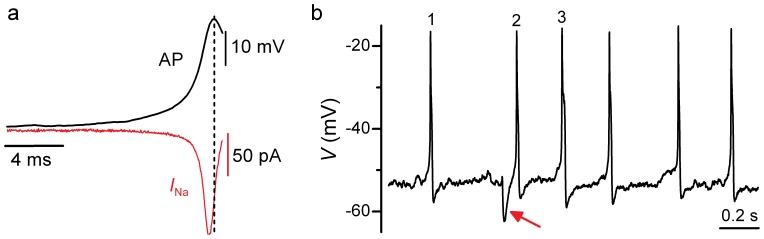
Role of the Na+ current in action potential activity.
a, A spontaneous action potential (AP: top trace) was used as a voltage command to elicit I
Na (bottom trace) from the holding potential of −60 mV in four P2–P3 apical IHCs. The AP was recorded from an immature IHC under current clamp conditions at body temperature. b, Spontaneous action potential activity under current clamp recorded from a P2 basal IHC. The arrow indicates a spontaneous IPSP due to currents flowing through ACh receptors.